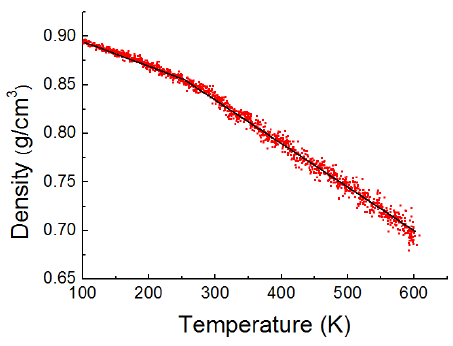
Figure 1. Temperature dependence density of the PE(150 – 20)/S model.